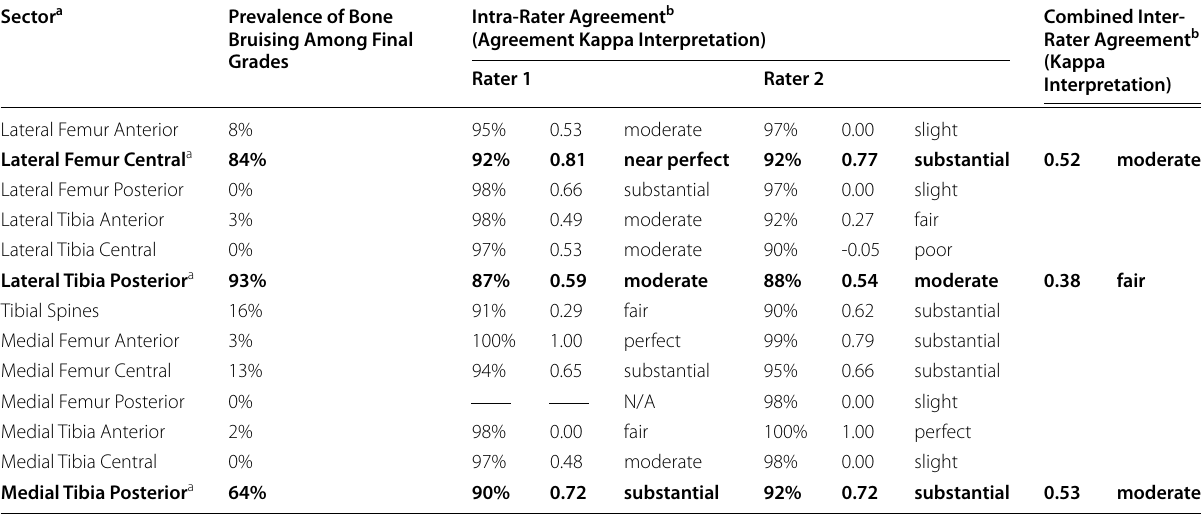
a Bolding indicates sectors where bruising was present on > 50% of all reads b Weighted agreement (i.e., larger discrepancies between grades affect agreement more than smaller discrepancies, interpretations per Landis & Koch (1977)